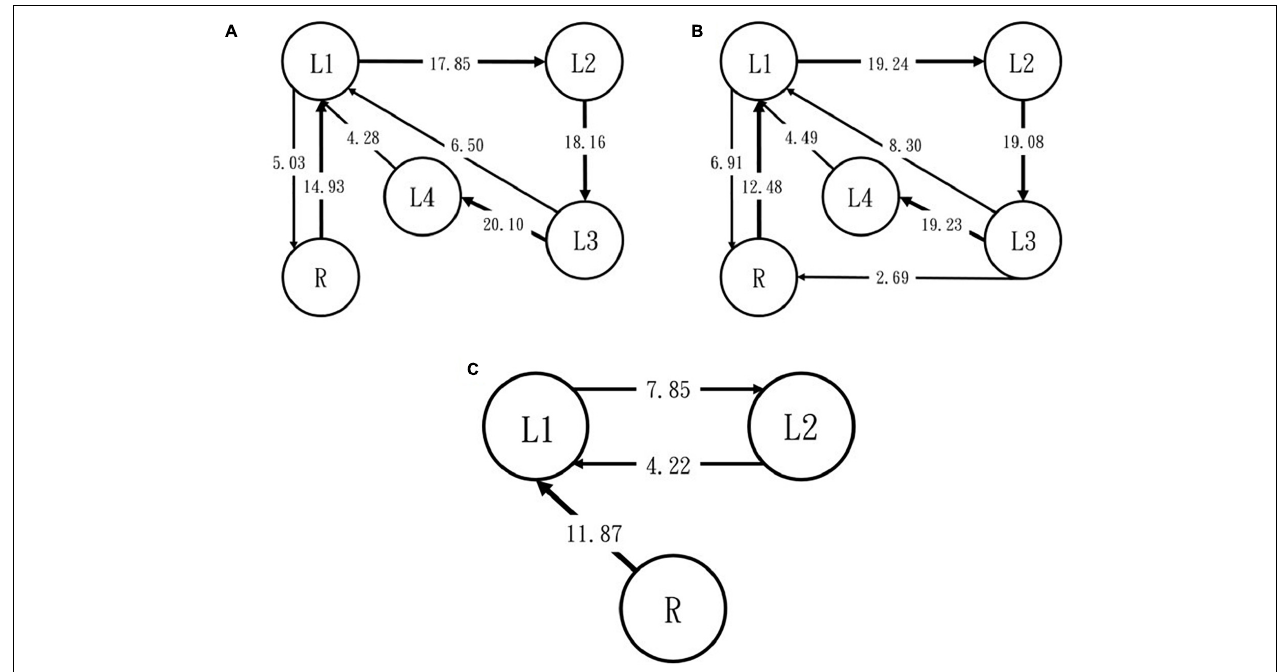
FIGURE 6 | Sequential analysis of learning